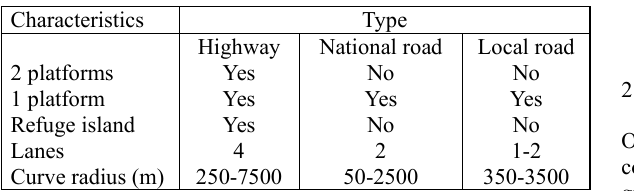
Table 1 . Some road alignment normatives (Ley 3.1-IC de Trazado de Carreteras, 2016) .